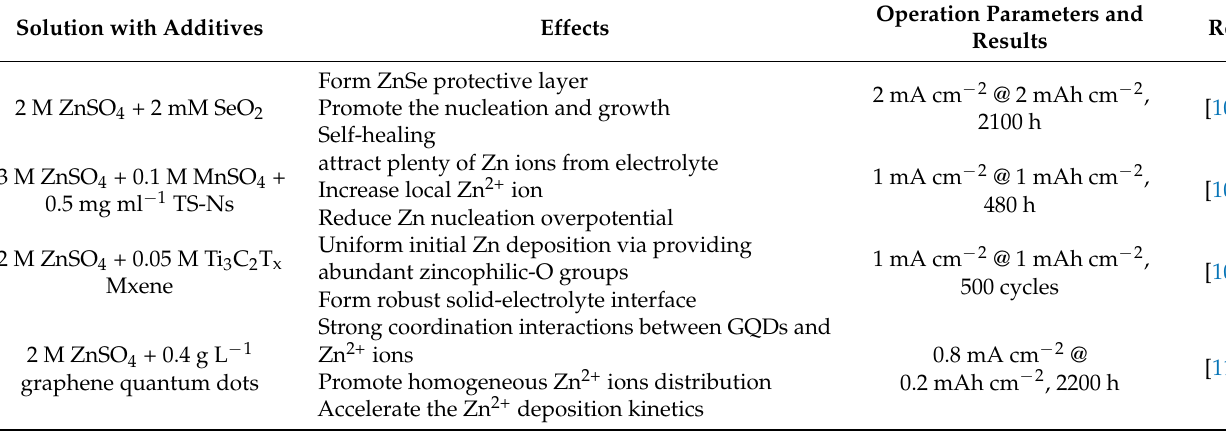
Table 3. Inorganic additives and effects in ZIBs.